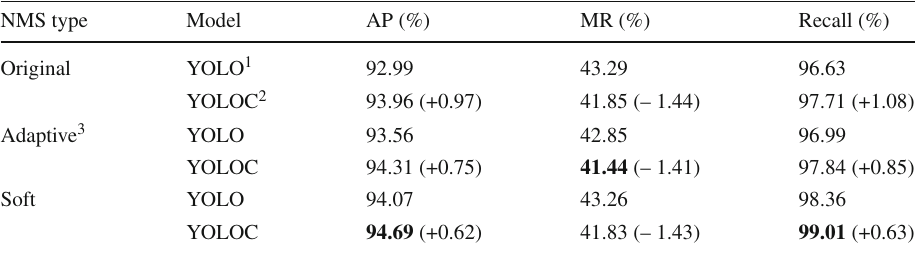
Table1shows theablationexperiments of theproposedSPCS module. The baseline is Scaled-YOLOv4 with three differ- ent NMS methods. For original NMS, we set IoU threshold Table 1 Ablation studies on